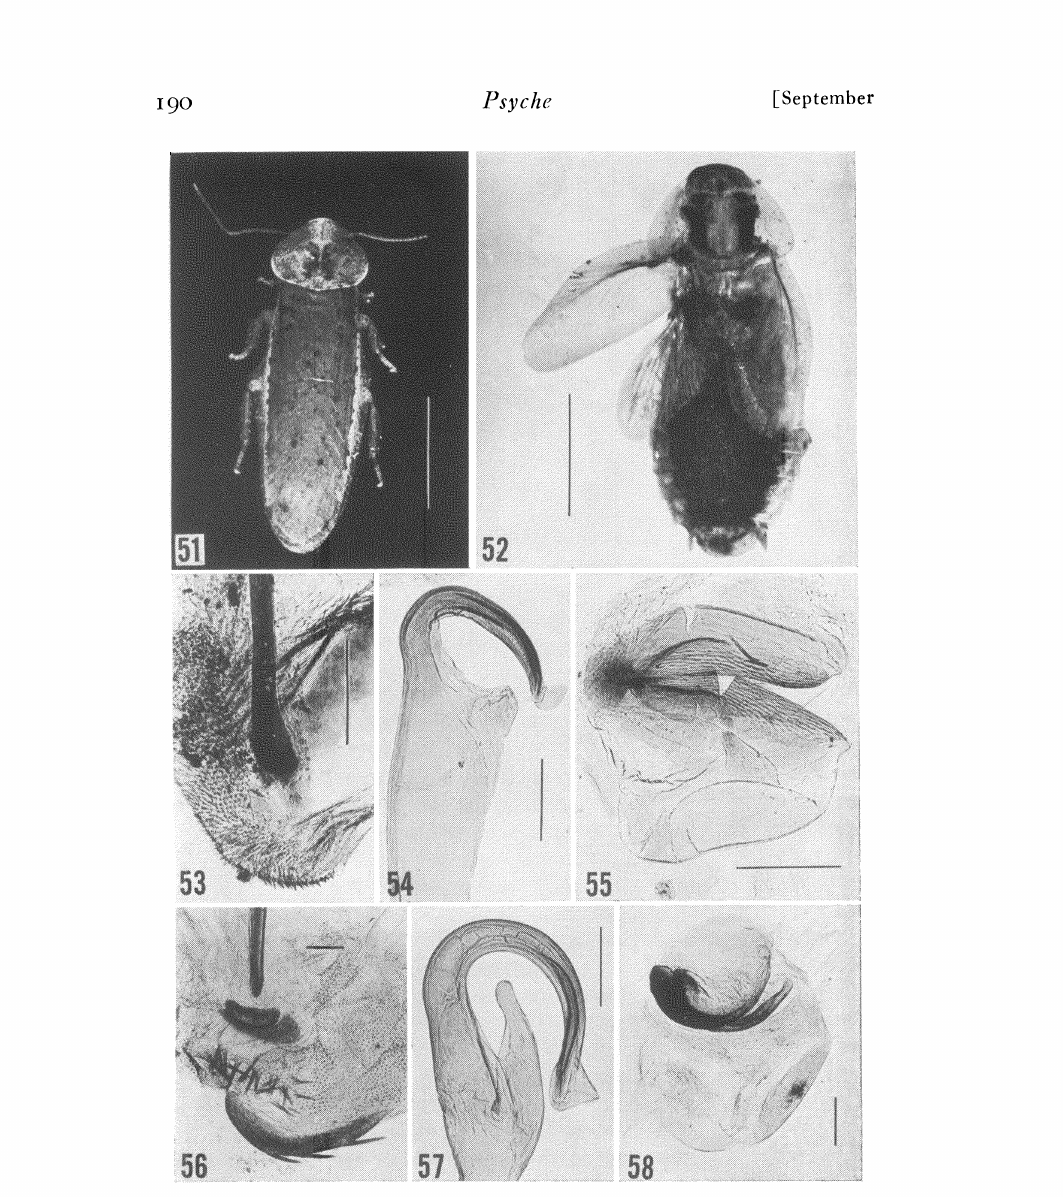
Figs. 51-58. Adult males and male genitalia of Blaberidae. 51. "’Isch- noptera" sicca Walker. Near Serra Tamendaui, Rio Negro, Amazonas (det. Roth). 52. (189 USNM). Pinaconota sp. Ilha das Alcatrazes, Paulo, Brazil. (det. Rehn). 53-55. "Ischnoptera" sicca (same data as speci- men shown in Fig. 51). 56-58. (189 USNM). Pinaconota sp. (from speci- men shown in Fig. 52). (scale for adults mm., for genitalia 0.2